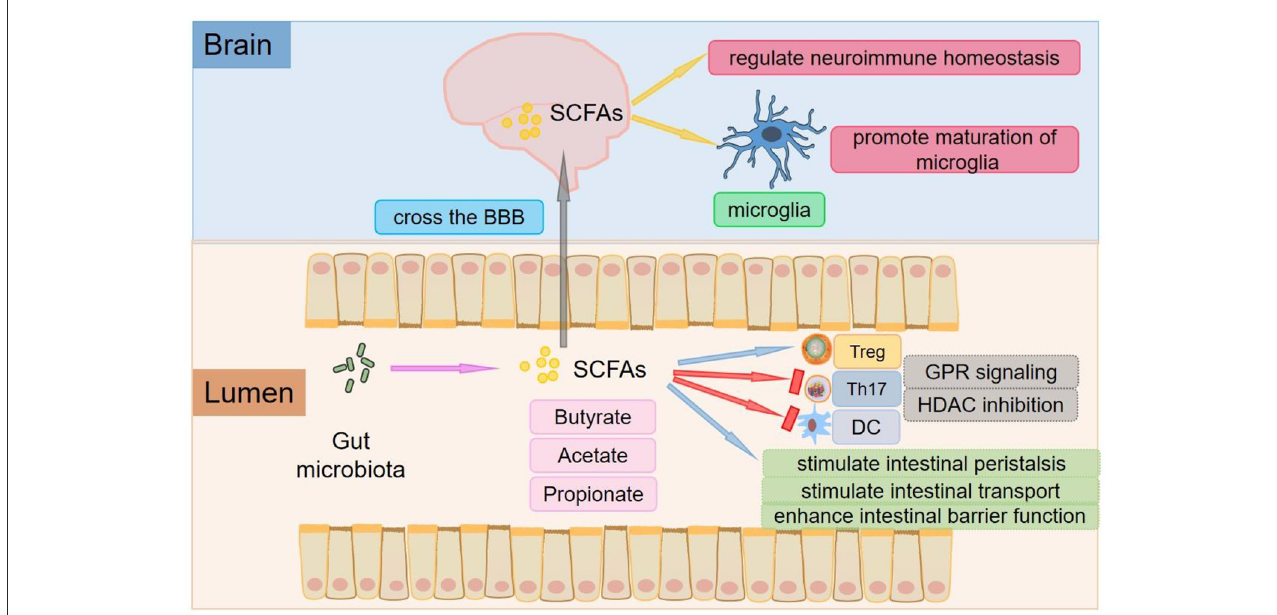
FIGURE1 The roles of SCFAs. The main SCFAs are acetate, propionate, and butyrate, which are produced in the process of microbial fermentation of indigestible dietary fibers or resistant starch. SCFAs are key mediators of metabolism and immune cell function in the gut mucosa and can stimulate intestinal peristalsis and intestinal transport and affect the integrity of the intestinal barrier. SCFAs exert anti-inflammatory effects beyond the gut, which help increase the number of Tregs and inhibit the differentiation of Th17 cells. SCFAs can promote the differentiation of Tregs by inhibiting HDAC or activating GPR109A/HCA2. Tregs can inhibit the function of antigen-presenting cells and other effector T cells and suppress immune responses. SCFAs also inhibit DCs development and regulate antigen presentation of DCs by inhibiting HDAC and interacting with FFARs. SCFAs can not only cross the BBB and control neuroimmune homeostasis but also play an important role in the recovery and maturation of microglial